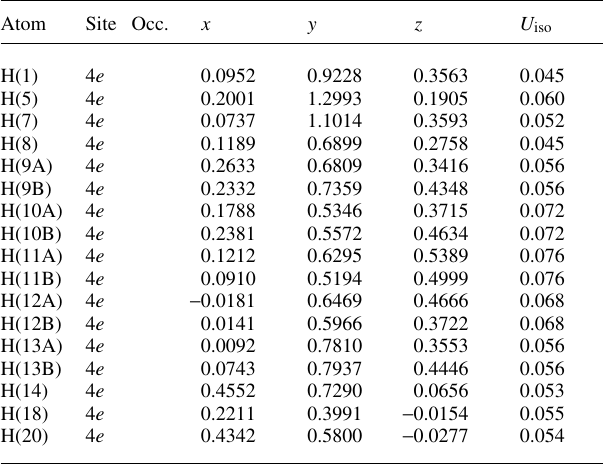
Table 2. Atomic coordinates and displacement parameters (in Å 2 )